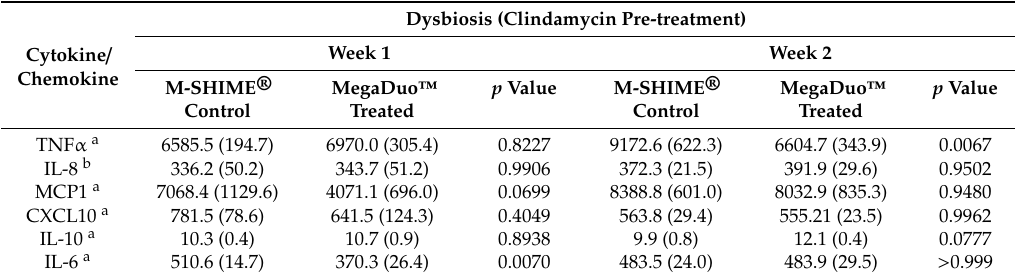
Table 1. E ff ect of M-SHIME ® supernatants on cytokine and chemokine release in the co-culture system under conditions of